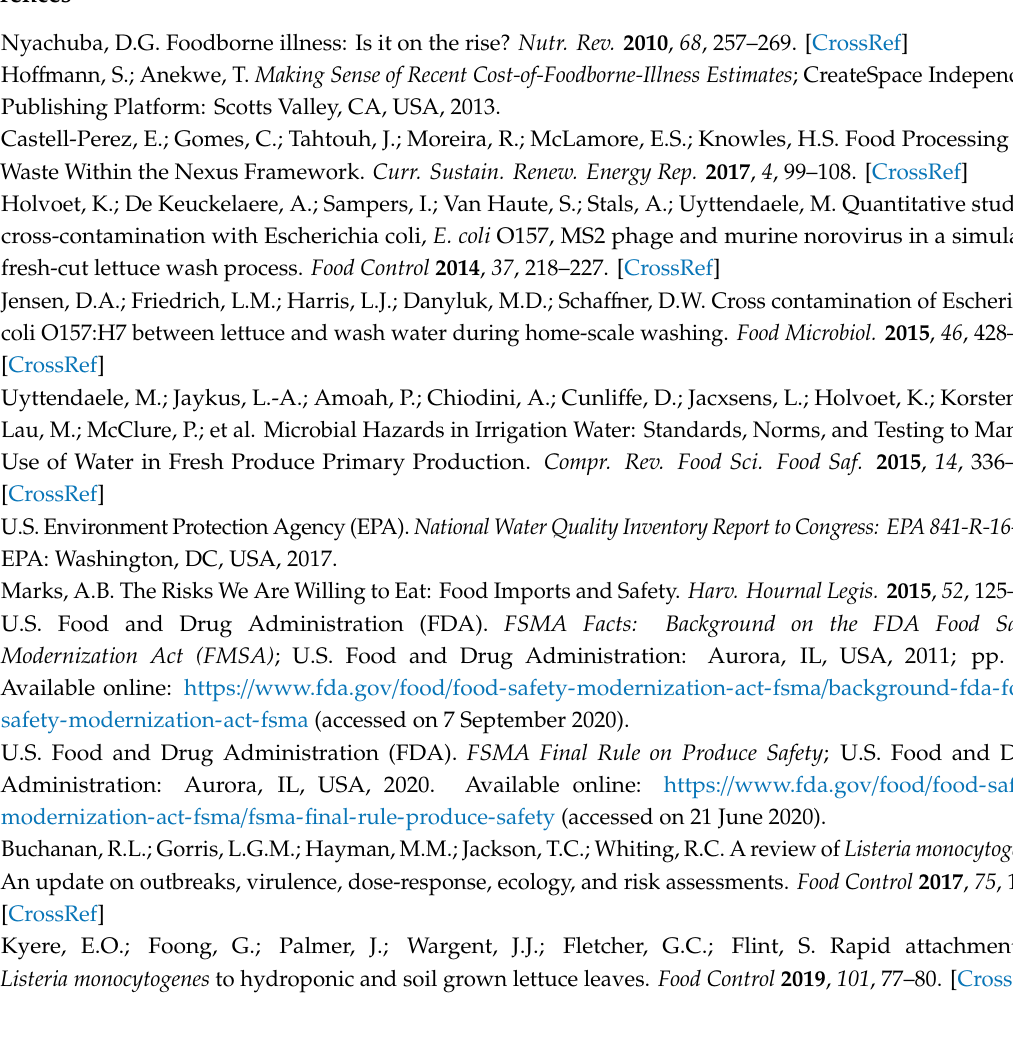
with Dektak profilometer measurement, Figure S4: (A) IME model output for various gap spacing (COMSOL). (B) comparison of measured and predicted capacitance for various gap spacing in bu ff er, Figure S5: (A) estimation of cell constant and electrode spacing for IME (B) Olthius plot (C) simulation of electrical field at the surface of IME, Figure S6: representative plots of electrochemical characterization of Ti / Pt IME with di ff erent gap spacing, Figure S7: representative DCPA for Pt-IME with 50 (A, B) and 100 (C, D) µ m gap spacing, Figure S8: cartoon representation of secondary structure predicted using mfold, Figure S9: cartoon representation of ferricyanide redox probe near the surface of Pt-IME with no aptamers, Figure S10: cartoon representation of redox probe used to measure electrochemical behavior, and Figure S11: (A) photograph of hydroponic system with Pt-IME. (B) Pt-IME incorporated into particle flow trap for continuous analysis. Table S1: materials and design dimensions for Pt-IME fabrication, Table S2: design characteristics of IME with various spacing and measured physical features using Dektak profilometer, Table S3: summary of electrochemical characterization using ferrocyanide as the redox probe, Table S4: portfolio analysis for IME with various gap spacing, and Table S5: cleaning electrodes with Piranha